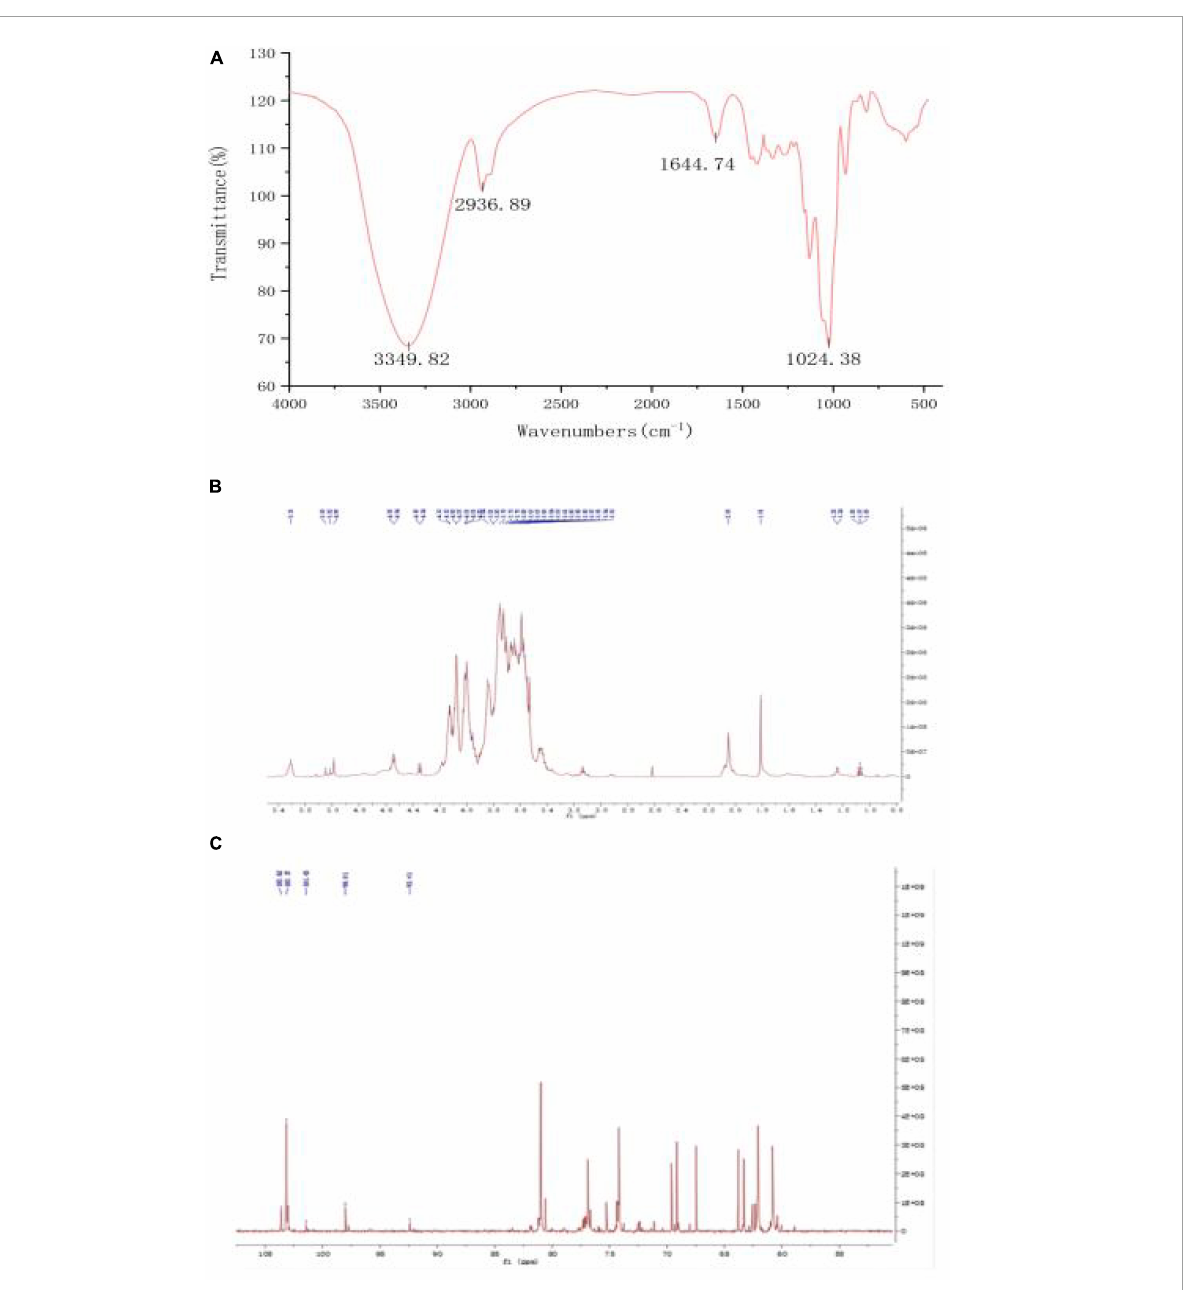
region, namely δ 5.35 ppm, δ 5.05 ppm, δ 5.02 ppm, δ 4.99 ppm, and δ 3.55 ppm. It indicated that both α − and β − glycosidic bonds in PSP-NP. δ 5.35 ppm were anomeric protons of the 1,4- α -D-Glc residue, and δ 5.05 ppm was an anomeric proton of the T- α -D-Man residue, while δ 5.02 ppm belonged to T- α -D-Glc. δ 4.99 ppm and δ 3.55 ppm belonged to the anomeric proton with 1,4- β -D-Gal and 1,4,6- β -D-Gal residues, respectively. The rest of the signals belonged to H2 ∼